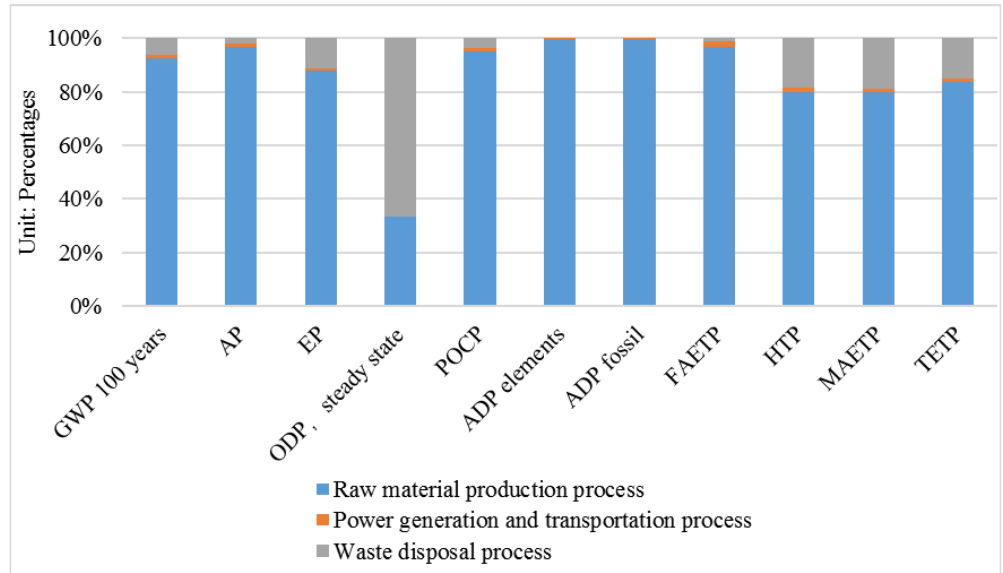
Figure 5. Contribution rate of the environmental impact potential of photovoltaic power plants at each stage.